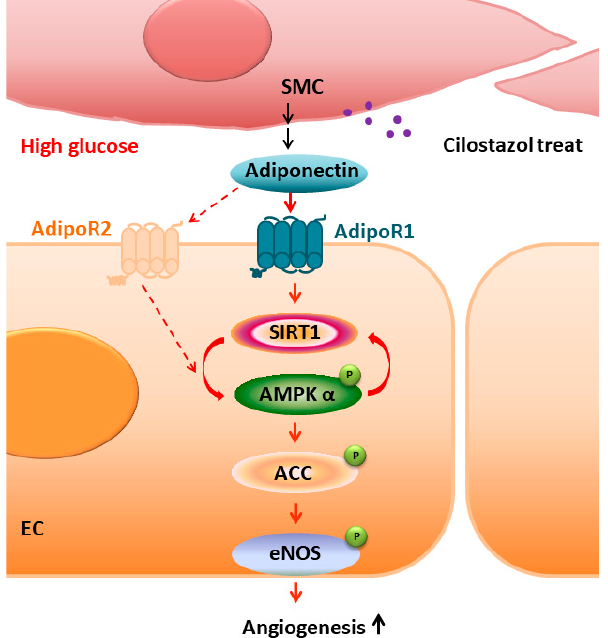
Figure 7. Schematic diagram shows the vascular angiogenic effects of cilostazol through stimulation of adiponectin secretion, adipoRs (mainly adipoR1), and the SIRT1 signaling pathway. ACC: acetyl- coenzyme A carboxylase; adipoR1: adiponectin receptor 1; adipoR2: adiponectin receptor 2; AMPK: adenosine monophosphate-activated protein kinase; EC: endothelial cell; eNOS: endothelial nitric oxide synthase; SIRT1: sirtuin 1; SMC: smooth muscle